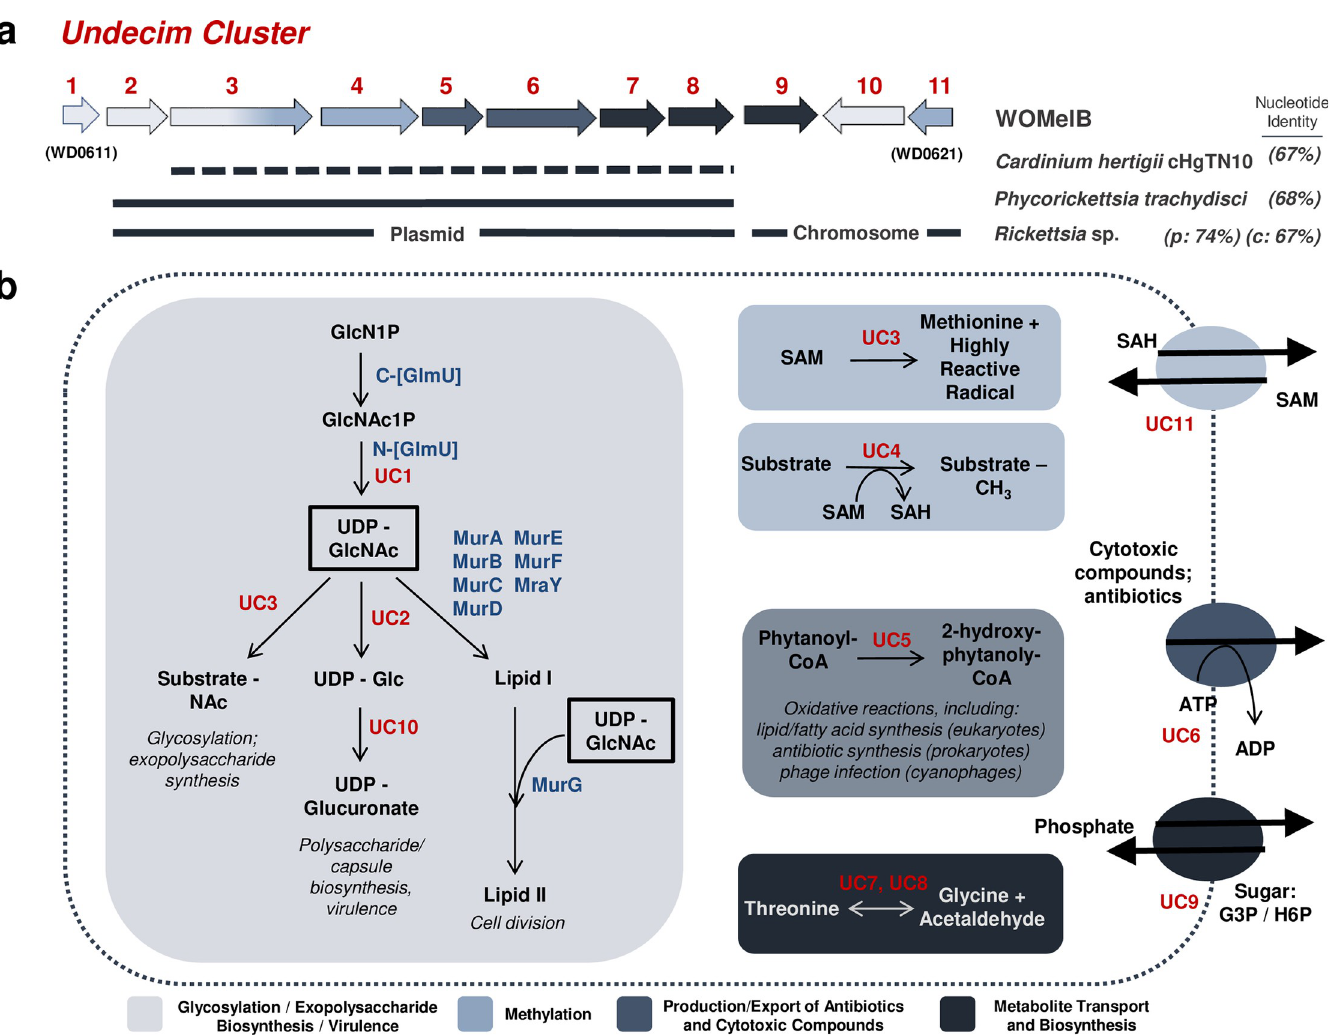
Fig 5. The Undecim Cluster contributes a wide range of cellular processes associated with host-symbiont interactions. (a) A genome map illustrates prophage WO’s Undecim Cluster. Gene labels UC1—UC11 correlate with w Mel locus tags WD0611-WD0621. Lines under the genes indicate lateral gene transfer events of this region between Cardinium hertigii cHgTN10, Phycorickettsia trachydisci , and multiple strains of Rickettsia , including the Rickettsia endosymbiont of Ixodes scapularis (REIS) and its plasmid (pREIS2). Nucleotide identity is listed to the right. Dashed lines indicate that the region is not contiguous in the genome. UC1 shares partial homology with a core Wolbachia gene, glmU (WD0133) and was either not involved in the transfer event or has since been lost from non- Wolbachia genomes. (b) A cellular model illustrates the putative functions associated with this region. Cellular reactions are highlighted in boxes and membrane transporters are drawn as ovals. Wolbachia genes are labeled in blue; Undecim Cluster genes are labeled in red. UC3 (WD0613) is a fusion protein with an N-terminal glycosyltransferase and C-terminal radical SAM domain; therefore, it is listed twice. Reactions in light gray (UC1, UC2, UC3, and UC10) are likely precursors to multiple pathways in glycosylation, exopolysaccharide biosynthesis, cell division, and/or virulence. Light blue (UC3, UC4, and UC11) is associated with methylation; dark gray (UC5 and UC6) is associated with the production and export of antibiotics and cytotoxic compounds; and dark blue (UC7, UC8, and UC9) is associated with metabolite transport and biosynthesis. The above functions are predicted based on annotation and homology to other systems. Given the contiguous conservation of the Undecim Cluster throughout prophage WO, all functions, including those not captured in this model, are likely interrelated and influence host-symbiont dynamics.